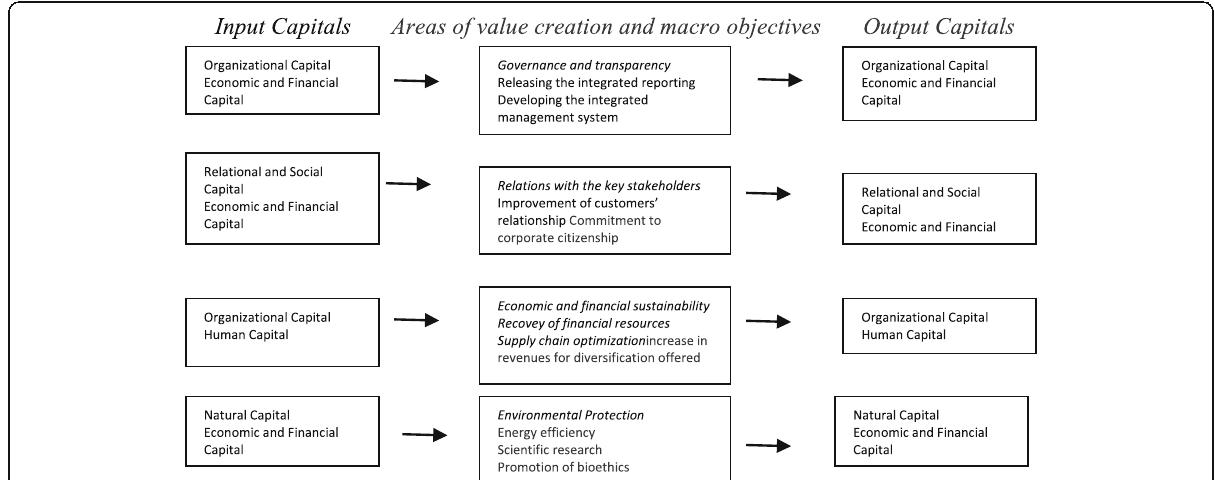
Fig. 1 Costa Edutainment ’ s model of value creation and connection with capitals. Source: our elaboration from Costa Edutainment Integrated Report, 2014: